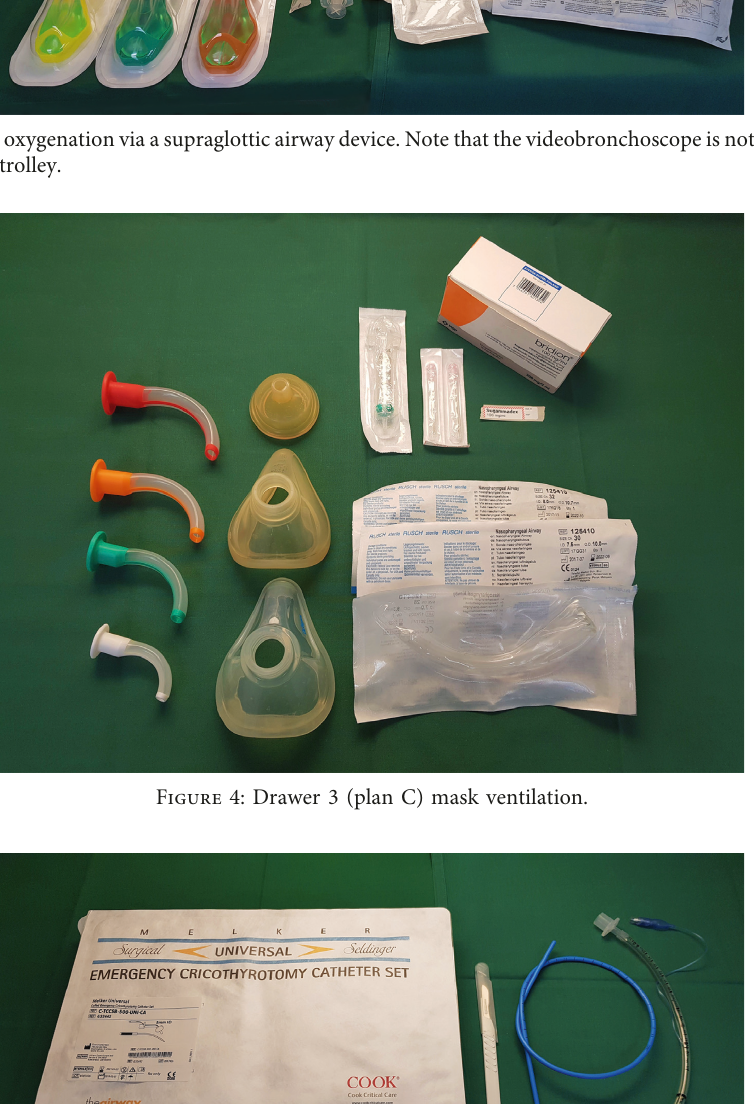
laryngoscope equipment and flexible intubating